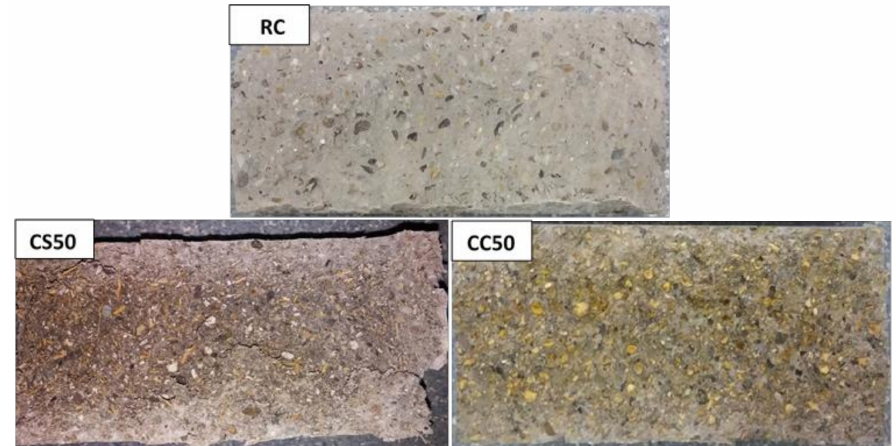
Figure 16. The RC, CS50, and CC50 cylinder’s section, after splitting tensile testing.